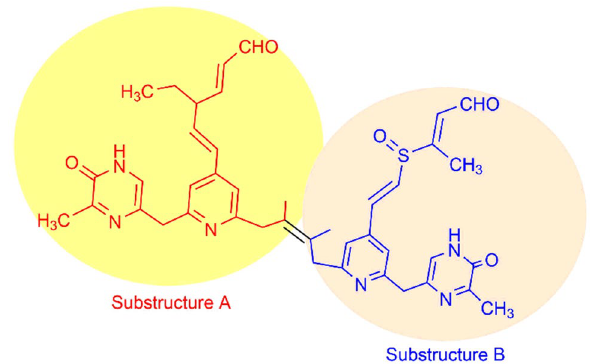
Figure 2. The total structure of pyrimidomycin with substructure A (in red) and B (in